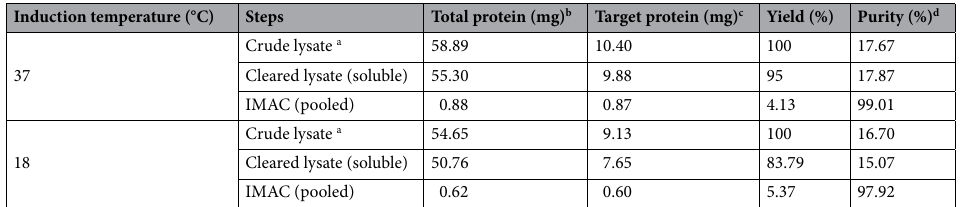
Table 1. Purification summary of recombinant human HTN-HAND2 protein. a From 1 g wet weight of induced E. coli BL21(DE3) cell pellet (from 0.25 to 0.35 L of culture). b Protein concentration determined by Bradford assay using BSA as a standard protein. c Determined from total protein concentration b and purity d . d Purity determined from SDS-PAGE analysis using ImageJ software.